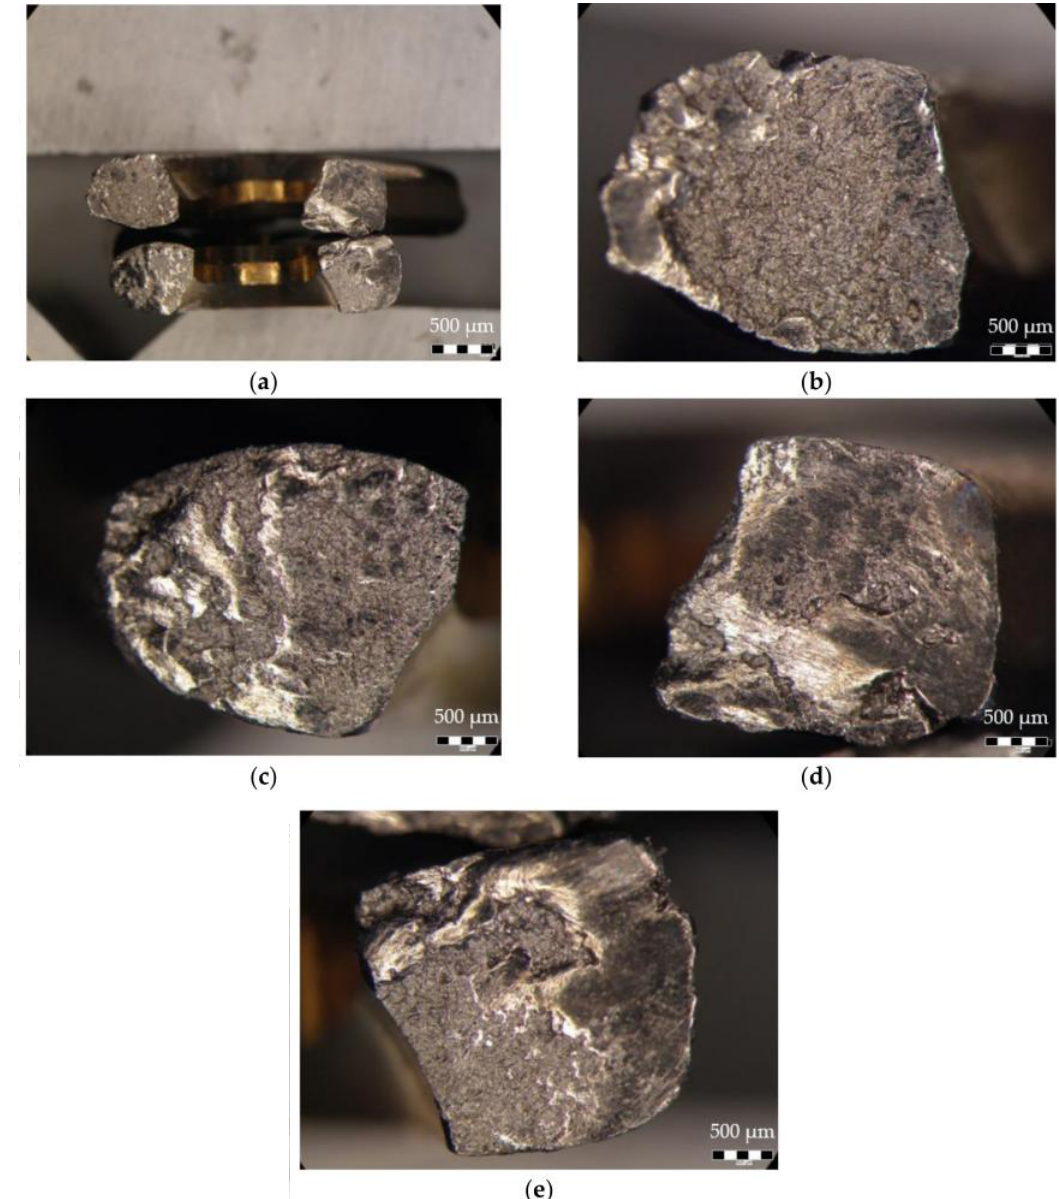
Figure 15. Fracture surface observed by stereomicroscopy: ( a ) overall fractographic image; ( b ) proximal side-posterior wall; ( c ) distal side-posterior wall; ( d ) proximal side-anterior wall; ( e ) distal side-anterior